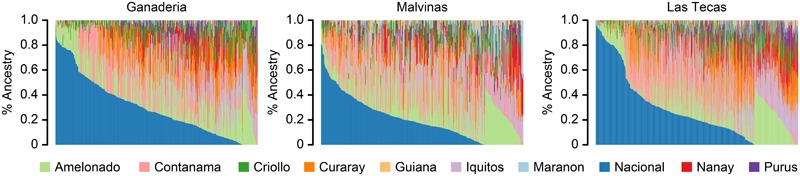
Ancestry proportions for 1,345 accessions from three cacao populations. Each accession is represented by a vertical line and derives its ancestry from up to 10 ancestral groups which are indicated by the various colors in the legend. Ancestry was estimated using supervised Admixture analysis using a genome-wide panel of 9,640 SNPs.